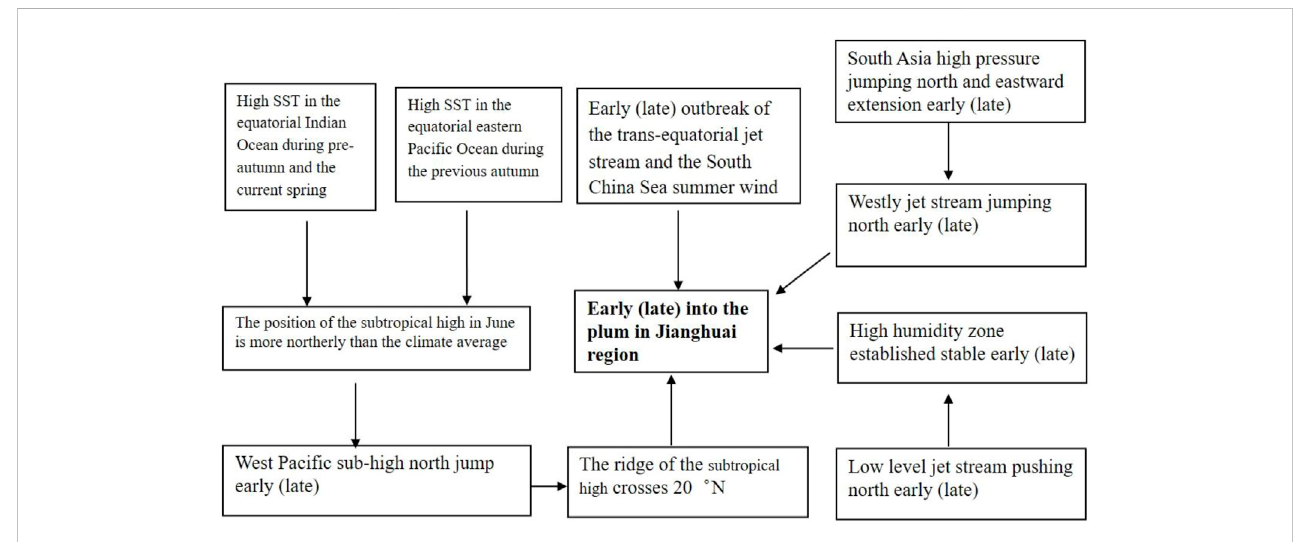
FIGURE 9 Conceptual diagram of the key in fl uence system for the Meiyu onset date over the Yangtze-Huaihe River Basin.